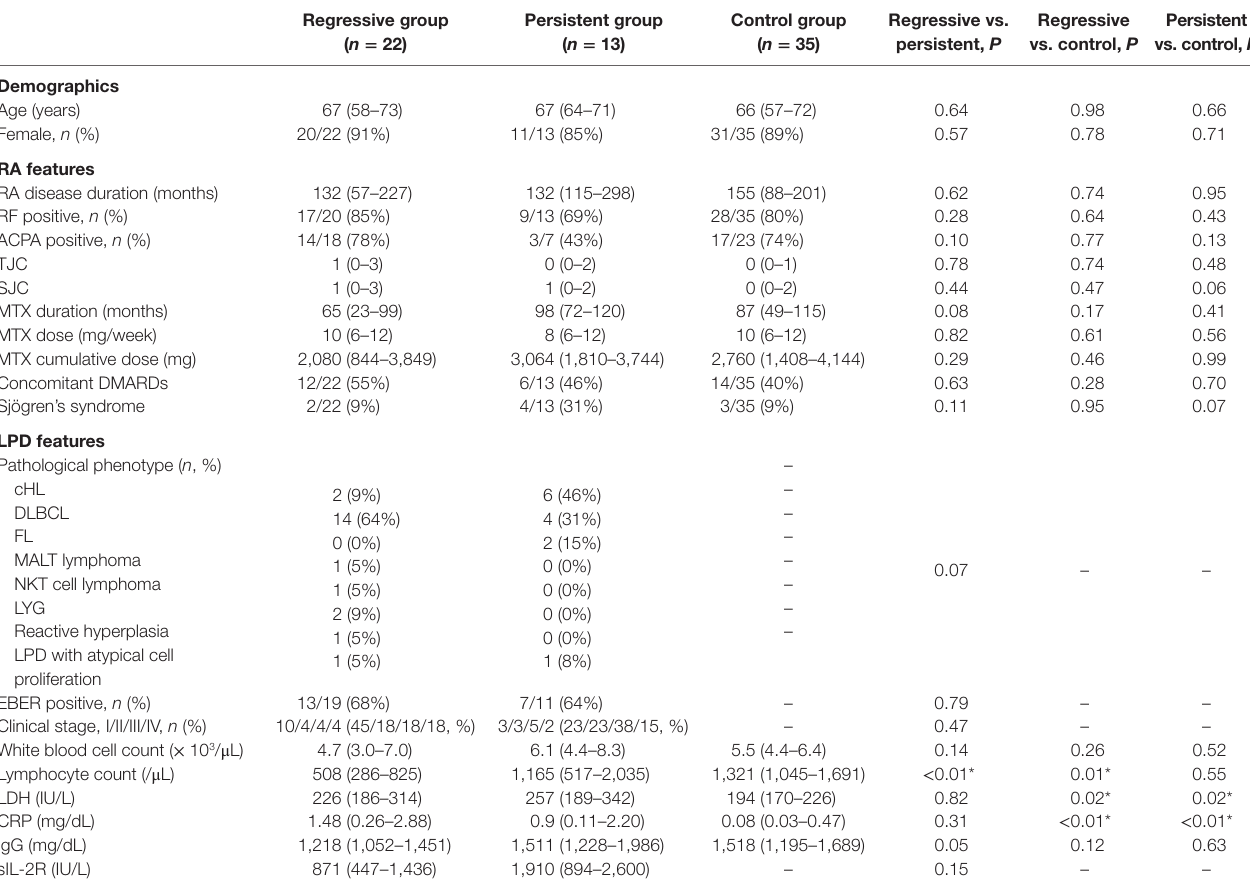
TaBle 1 | Characteristics of LPD and control RA patients.